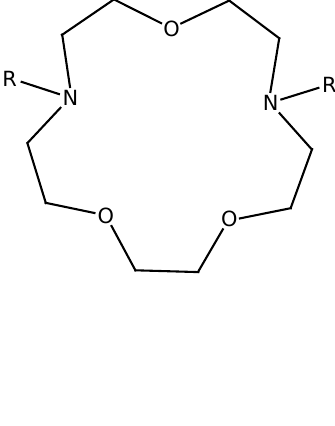
Figure 8. Azacrown